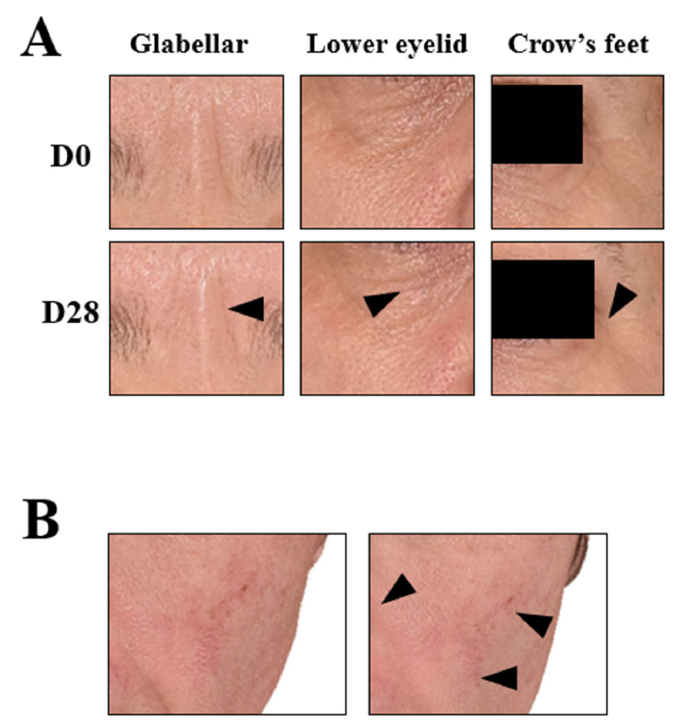
Figure 7. 3D reconstructive images of the face of selected subjects in frontal view. ( A ) Wrinkle im- provement of the periocular area (arrows); representative image of the mean of the wrinkle smoothing score. ( B ) Discoloration improvement in the nasal wing area and chick (arrows); representative image of the mean of the skin